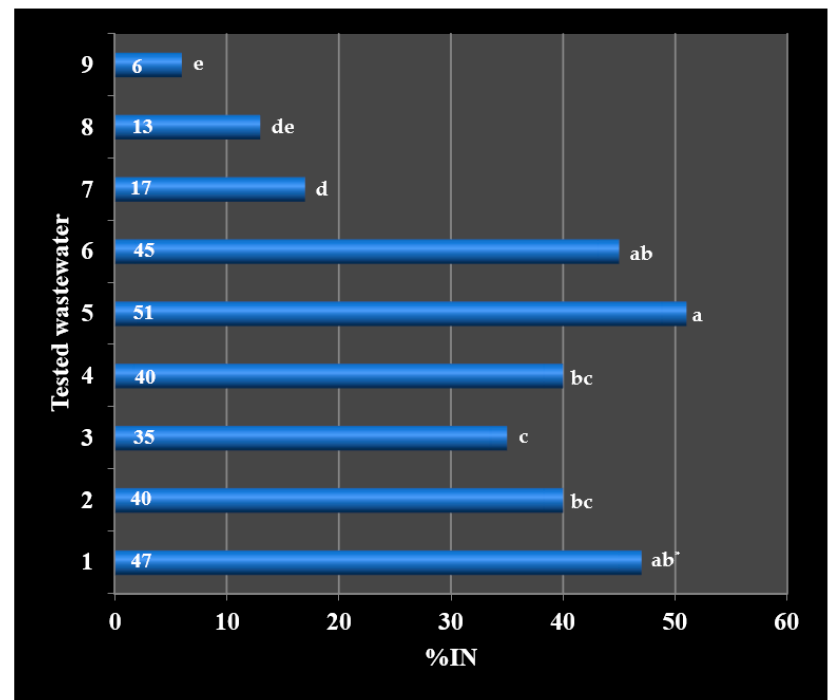
C–control; ATU–comparative inhibitor; production of: 1 styrene butadiene rubbers; 2 solvents: butyl acetate, ethyl acetate; 3 styrene; 4 acrylonitrile rubbers; 5 terpenes; 6 emulsifiers; 7 polyvinyl acetate; 8 polyvinyl chloride; 9 methacrylate. MLVSS—3.755 g·dm − 3 , specific nitrification rate—1.20, nitrify- ing activity of activated sludge—1.50.